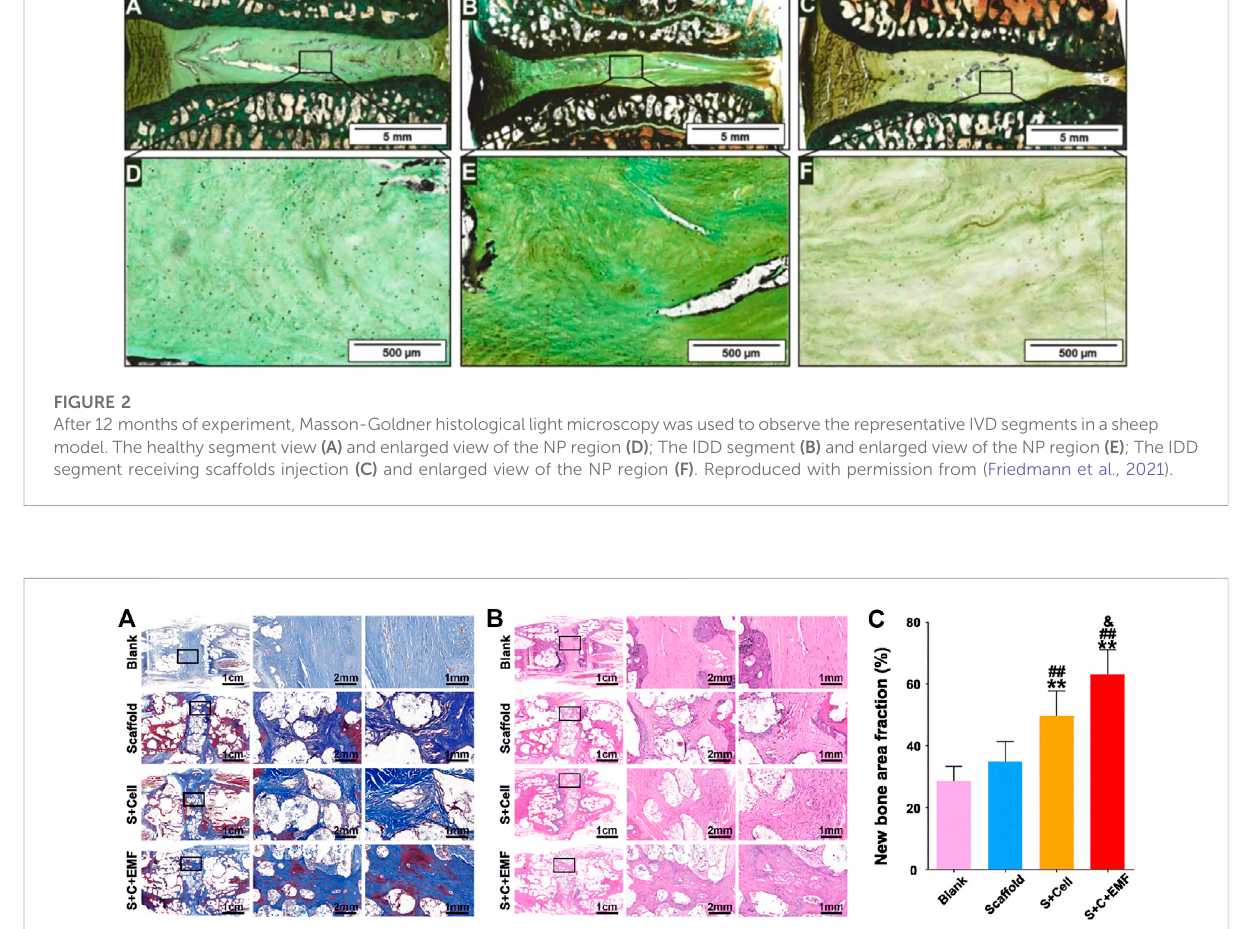
FIGURE 3 Masson trichrome staining (A) andHEstaining (B) wereused toobserve thenewboneformation inthescaffolds after 12 weeksofimplantation. Quanti fi cationanalysisofnewbonefractioninfourgroupsafter12 weeksofimplantation( n =6) (C) .**means p < 0.01comparedtotheblankgroup, ## means p < 0.01 compared to the only scaffold group, & means p < 0.05 compared to the S + Cell group. EMF: electromagnetic fi eld. Reproduced with permission from (Li et al.,